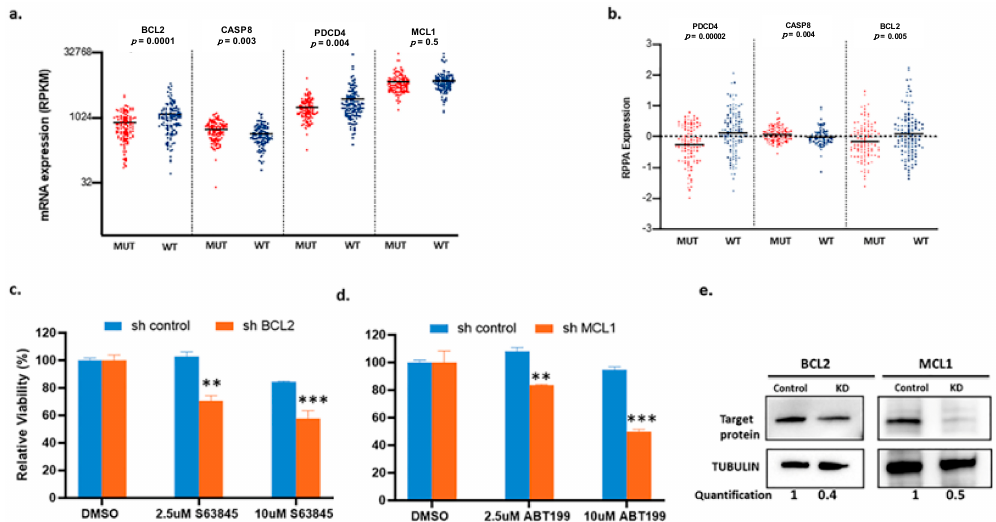
Figure 1. Di ff erential expression of apoptotic-related mRNA and proteins in The Cancer Genome Atlas Network (TCGA) cutaneous melanoma dataset and the e ff ects of knocking down B-cell CLL / lymphoma 2 (BCL2) or myeloid cell leukemia sequence 1 (MCL1). ( a and b ) Comparison between two genotypic groups: BRAF-hotspot mutated (MUT) ( n = 110) and BRAF-wild-type (WT) (harboring RAS hotspot mutated, any NF1 mutated, and triple wild type n = 122). ( a ) mRNA expression values for BCL2, CASP8, PDCD4, and MCL1. ( b ) Relative reverse phase protein array (RPPA) protein expression values for PDCD4, CASP8, and BCL2. MCL1 was not included on the RPPA panel. Each dot represents an individual sample, and the horizontal line represents the mean. ( c ) and ( d ) show the e ff ects of BCL2 or MCL1 knockdown in A375 cells. Cells were treated with the indicated drugs for 48 h. Knocking down BCL2 (shBCL2) sensitized cells to MCL1 inhibitor S63845 and knocking down MCL1 (shMCL1) sensitized cells to BCL2 inhibitor ABT-199. Y-axis shows percentage of relative viability and X-axis indicates the BH3 mimetics used. ** indicates p < 0.01; *** indicates p < 0.001. Error bars represent +/ − SEM. ( e ) Immunoblots to confirm the knockdown.